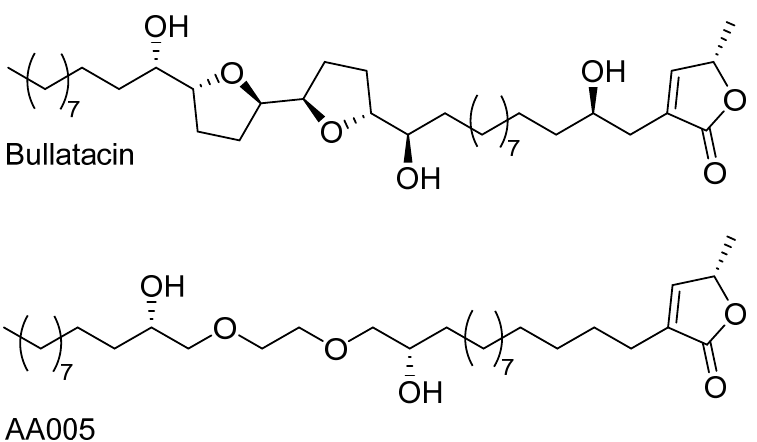
Figure 5. Structures of bullatacin and AA005.